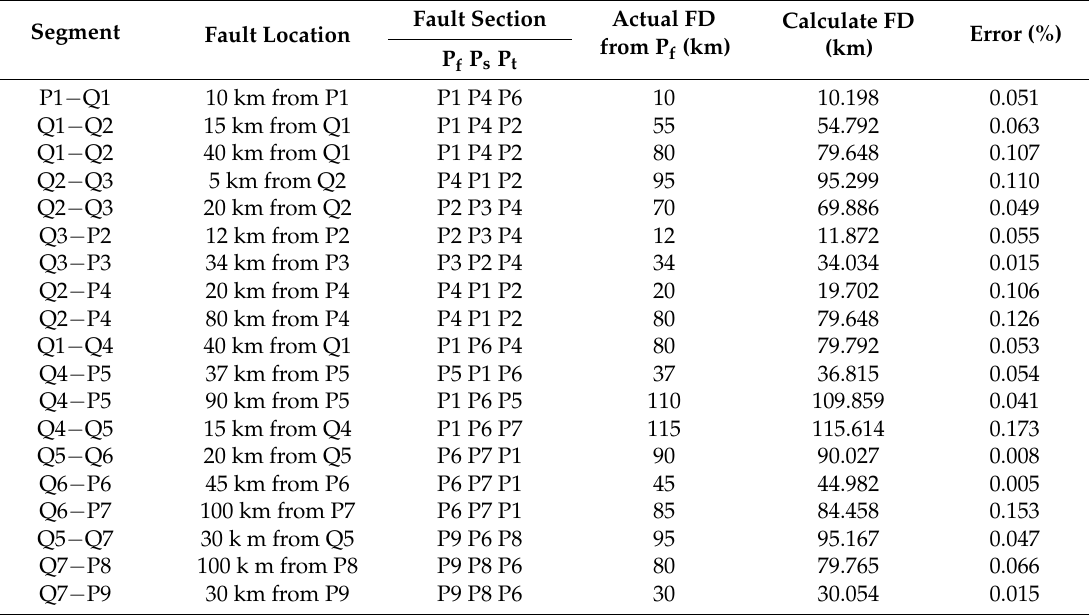
Table 6. Section identification and fault location results in different